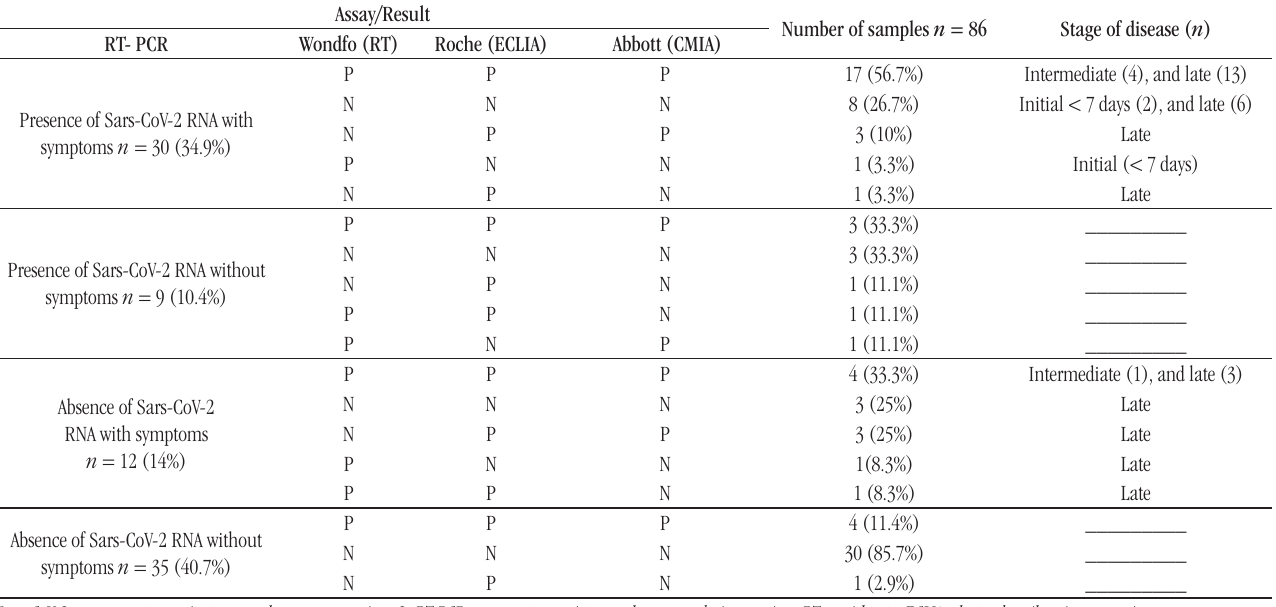
TABLE 3 – Performance of the three serological tests for anti-Sars-CoV-2 in serum samples from the epidemiological survey according to RT-PCR results Assay/Result Number of samples n = 86 Stage of disease ( n ) RT- PCR Wondfo (RT) Roche (ECLIA) Abbott (CMIA)